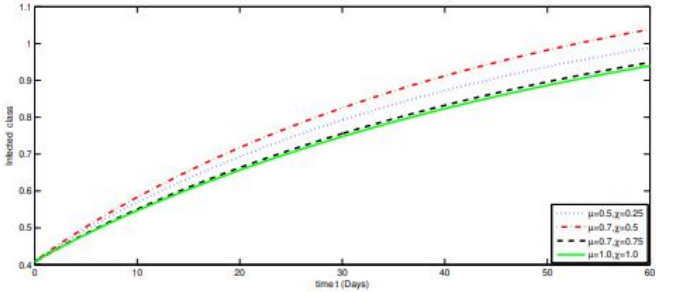
Figure 11. Graphs of numerical solutions at different fractal-fractional order for Infected class.